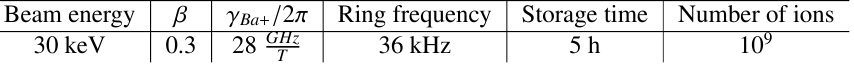
Table 1. Relevant parameters for the demonstrator storage